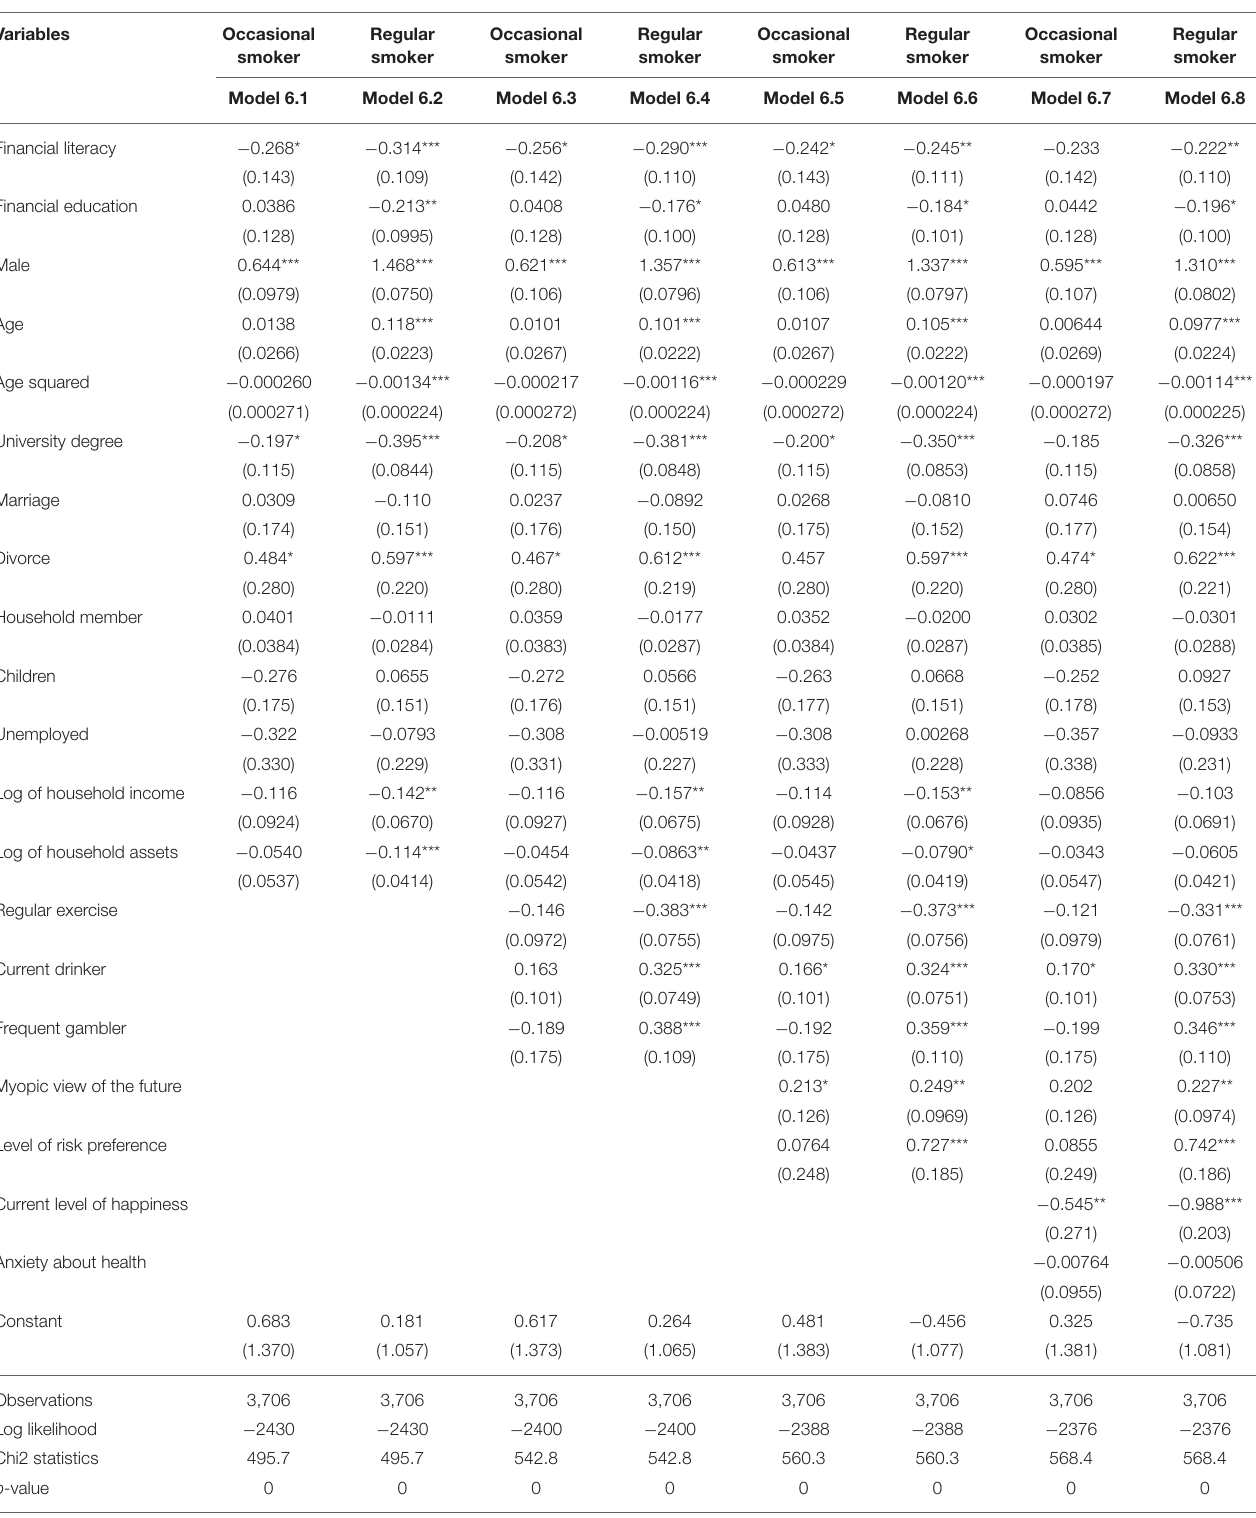
TABLE 11 | Multinomial probit model regression results, financial literacy, and financial education as the main explanatory variables.